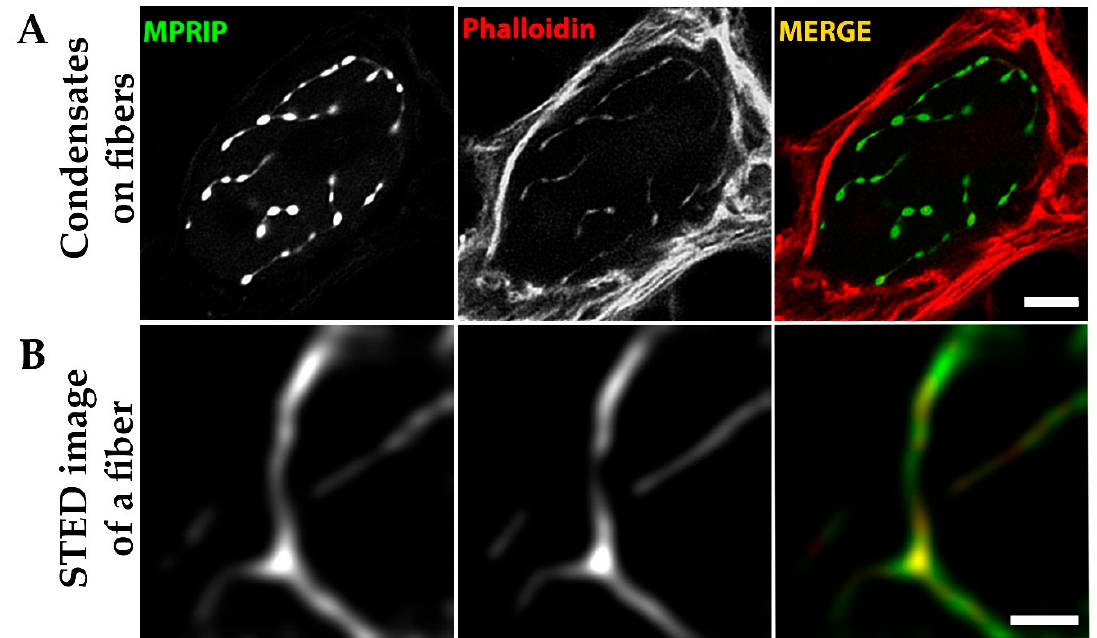
Figure 9. Phalloidin staining of the GFP-MPRIP overexpressing U2OS cells. Fixed GFP-MPRIP transfected cells were stained with phalloidin and investigated by confocal microscopy. ( A ) GFP-MPRIP condensates localized on phalloidin labelled fibers in cell nucleus. Scale bar represents 5 µm ( B ) GFP-MPRIP fibers visualized by STED microscopy. Blue is DAPI, green is GFP-MPRIP and red is the phalloidin staining. The scale bar represents 1 µm.